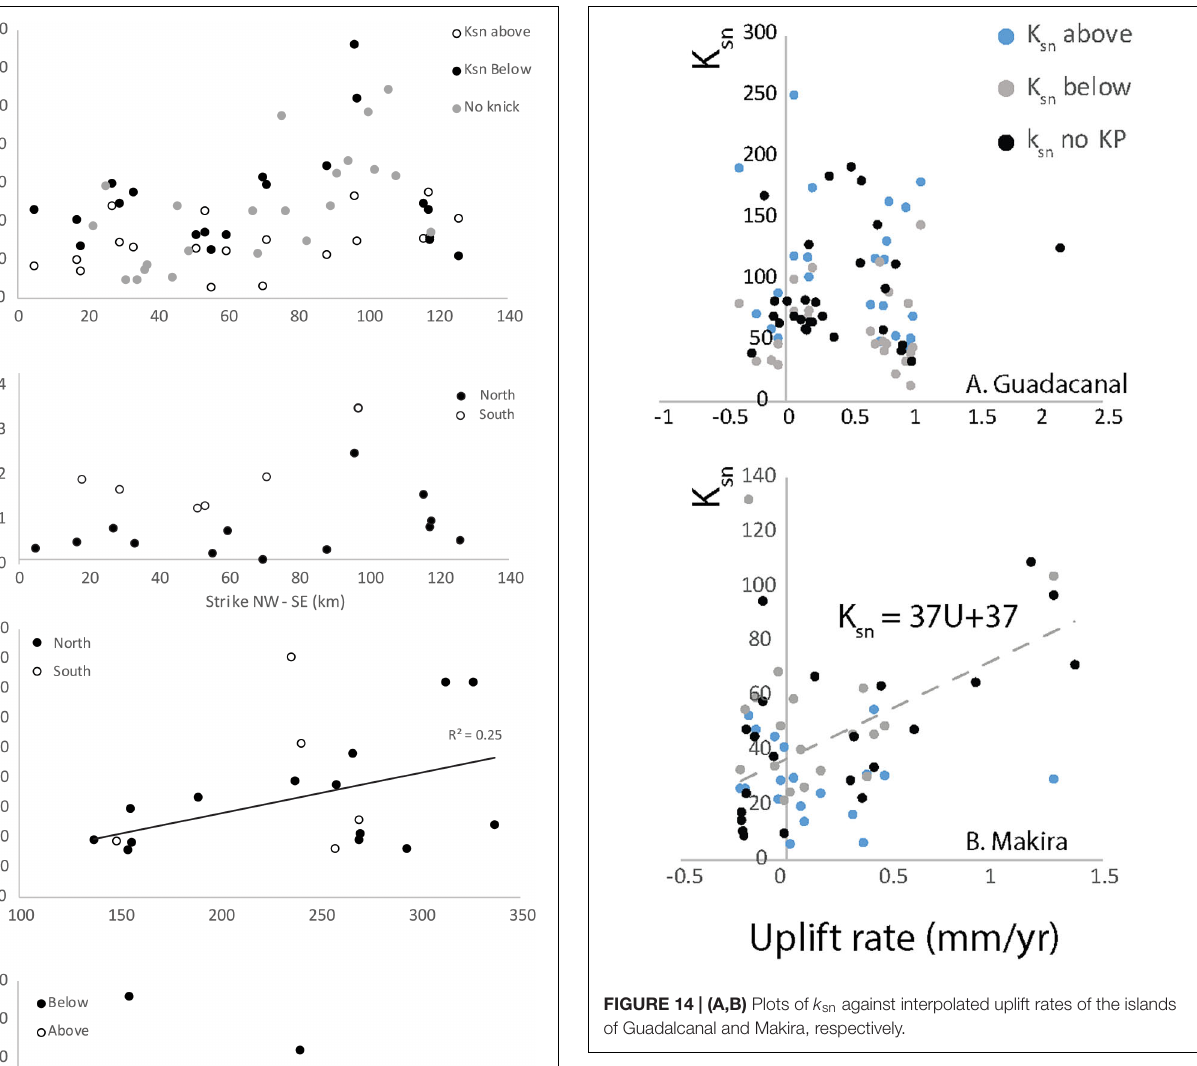
quantify given existing data, such as precipitation gradients across the island, variability in channel morphology or local rock strength variations not captured by regional scale